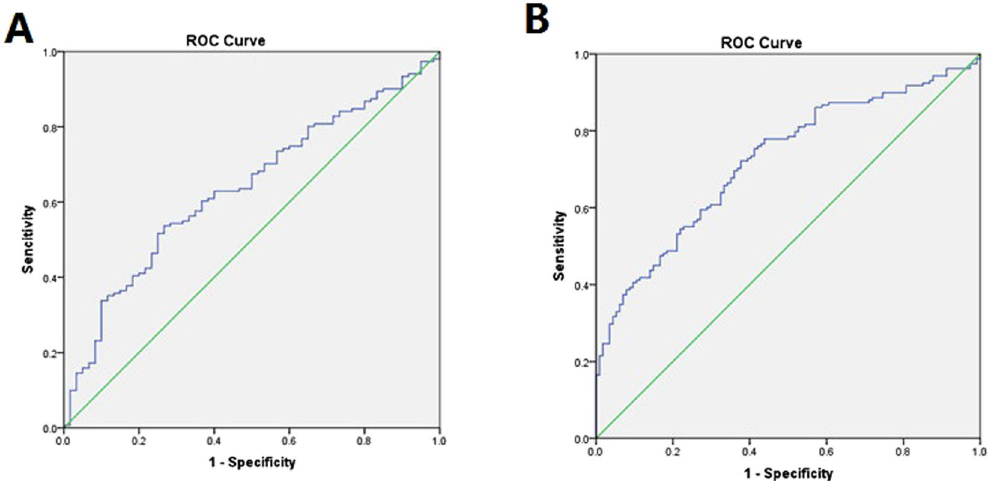
Figure 3. The receiver operating characteristic (ROC) curve analyses for the plasma H19 and LIPCAR as diagnostic biomarkers of CAD. The area under ROC curve (AUC) was 0.631 (95% CI = 0.551–0.788) for H19 ( A ) and 0.722 (95% CI = 0.669–0.782) for LIPCAR ( B ). The sensitivity and specificity at the optimal cut-off were 53.6% and 73.0% for H19 (cut-off value: 0.269), and 72.2% and 62.3% for LIPCAR (cut-off value: 0.344),